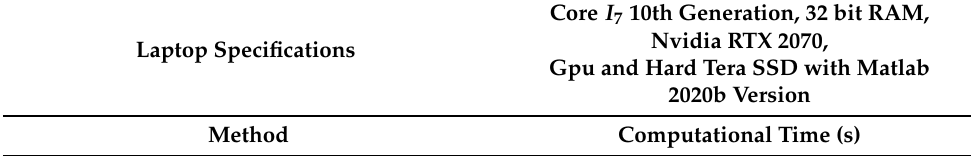
Figure 19. Accuracies rates for the proposed approaches . Table 12. Computational time of the examined approaches using dataset